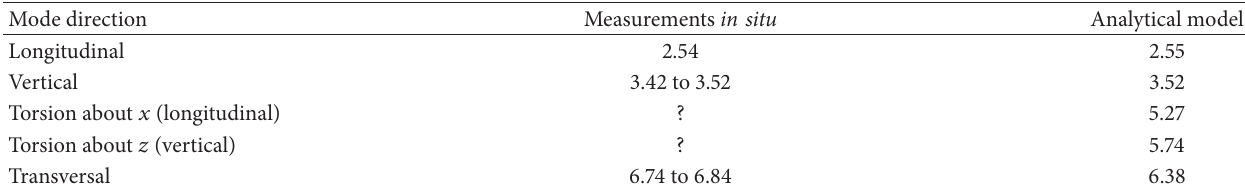
Table 5: Comparison of frequencies (Hz) between measurements in situ and the analytical model.